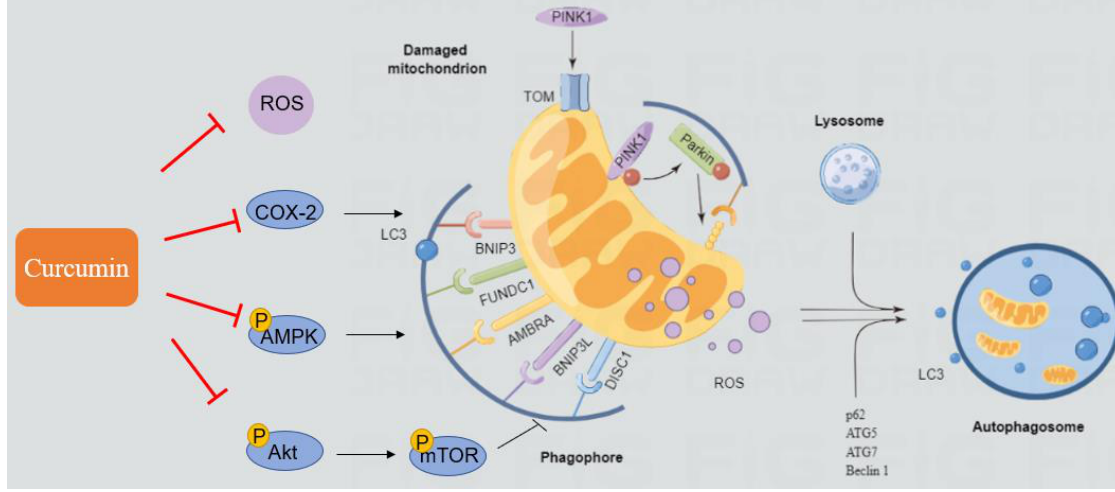
Figure 5. The regulatory effects of curcumin on AFB1-induced autophagy or